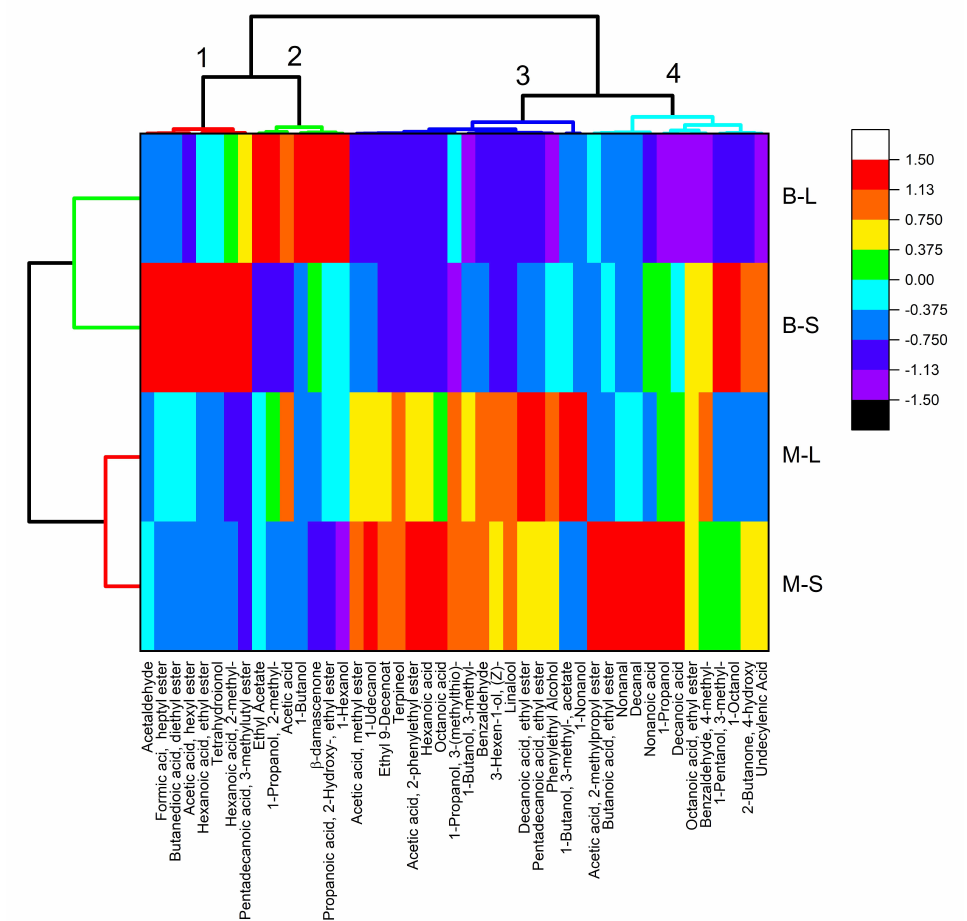
Figure 2. Heatmap and cluster analysis of the volatile compounds of the wines obtained by the combi- nation of grape cultivars (M—Minutolo, B—Bombino) and yeast starters (S— Saccharomyces cerevisiae , L— Lachancea thermotolerans ). The color map refers to the data of volatile compounds after standard- ization. Volatile compounds and wines are clusterized on the upper side and on the left-hand side of the heatmap, respectively. Clusters are indicated by different colors in the dendrogram. The numbers of the volatile clusters (1 to 4) refer to the discussion in the